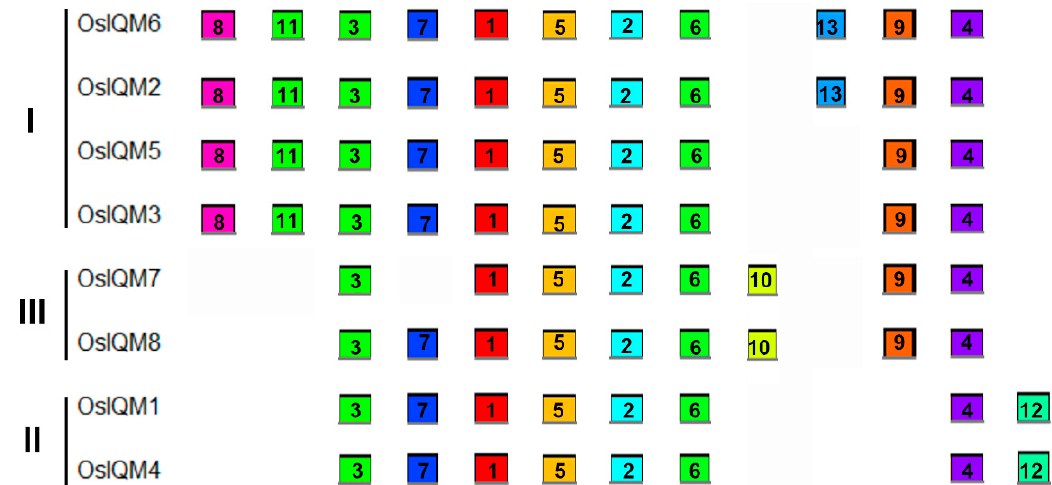
Figure 3. Motif distribution in IQM proteins of rice. Motifs of the OsIQM proteins were identified by the online MEME program. Each motif was represented by a different colored box with its serial number in central of the box. The colored boxes were ordered manually according to the results of the MEME server. The length of each colored box does not represent the actual motif size in the corresponding proteins.